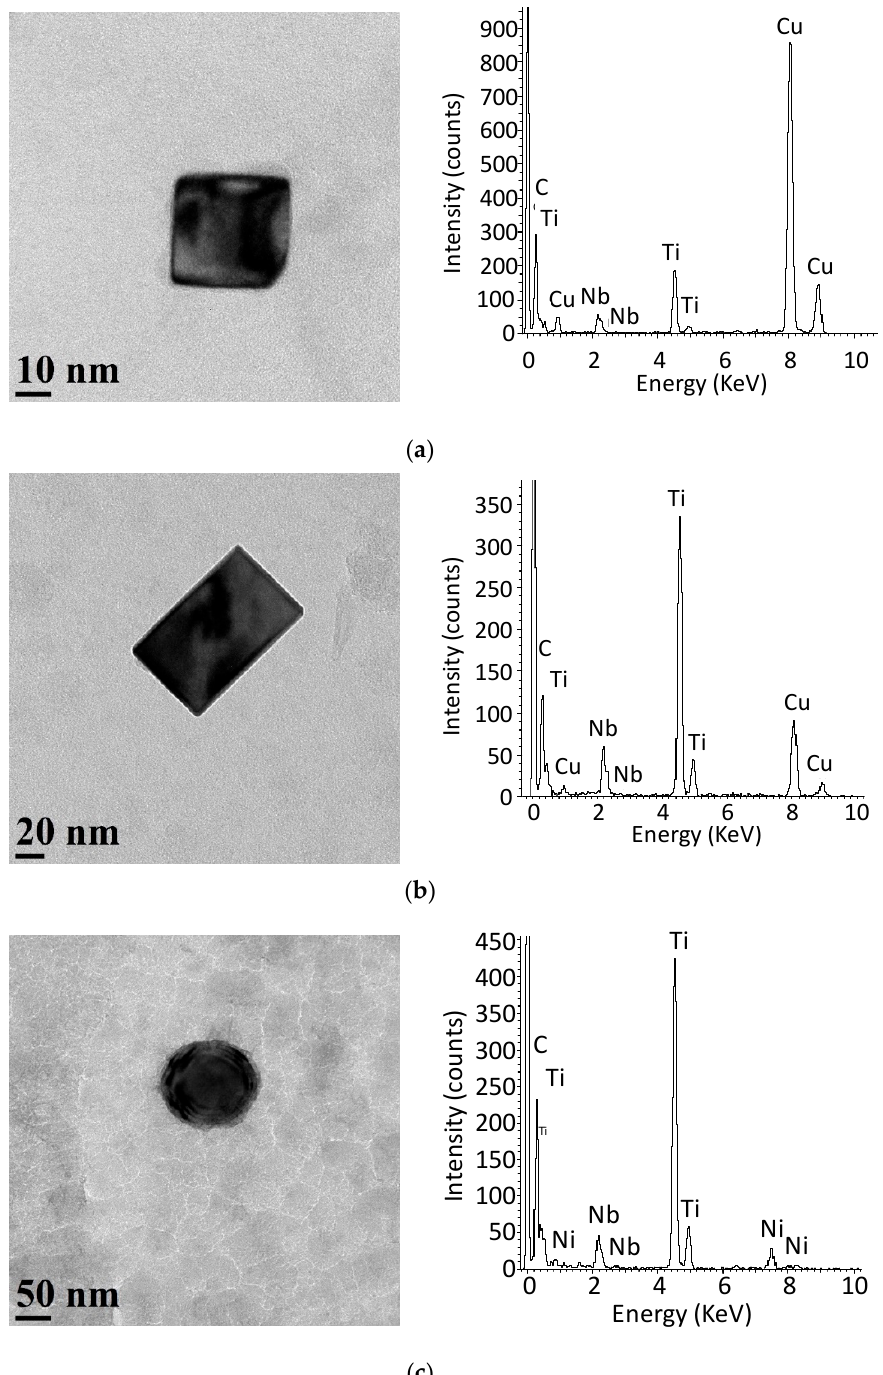
Figure 4. Examples of Nb-Ti precipitates found in the replicas extracted from the initial microstructure and corresponding EDS analysis. ( a ) Ti0Nb3 steel, ( b ) Ti5Nb3 steel, ( c ) Ti15Nb3 steel.